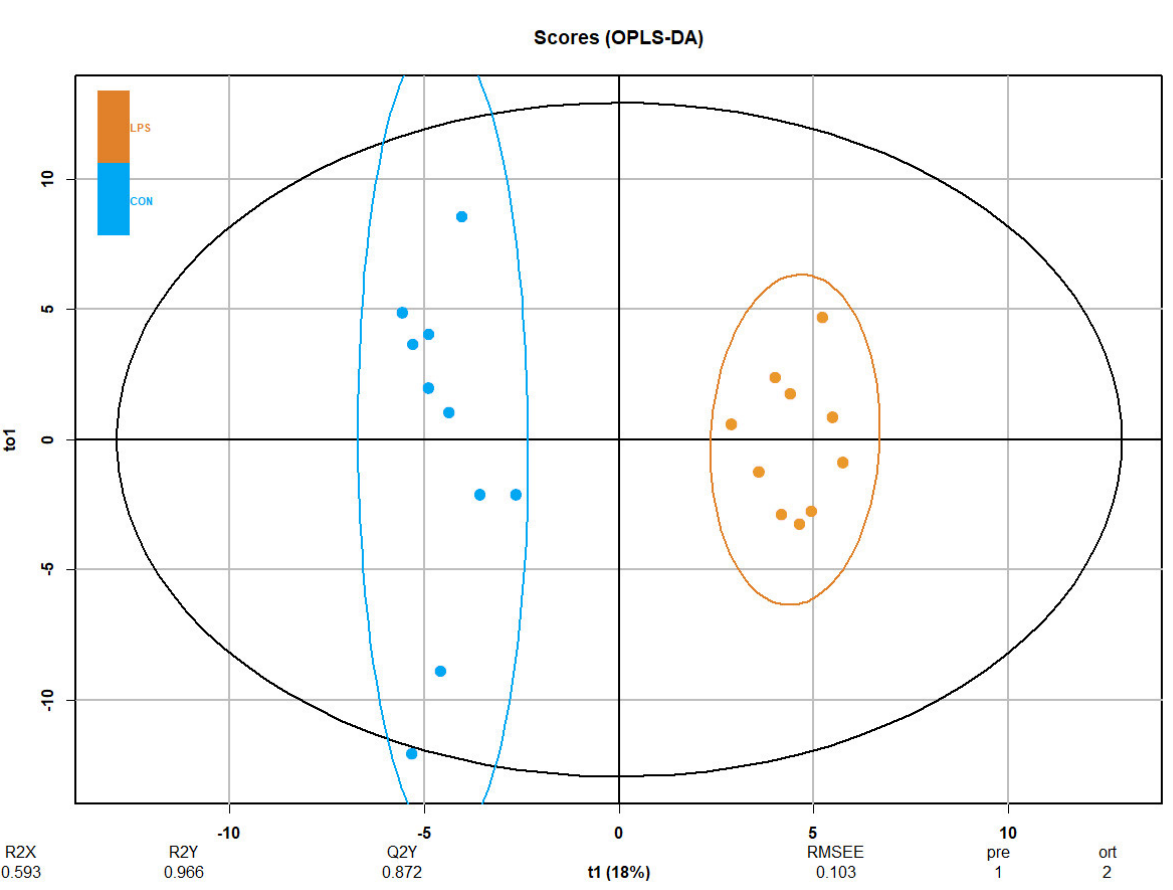
Figure 3. OPLS-DA of plasma metabolomics in the LPS-induced inflammation model. The Score plot is represented, and it includes the number of components and the cumulative R2X, R2Y and Q2Y. Blue represents CON group and orange LPS group ( n = 10 animals per group).